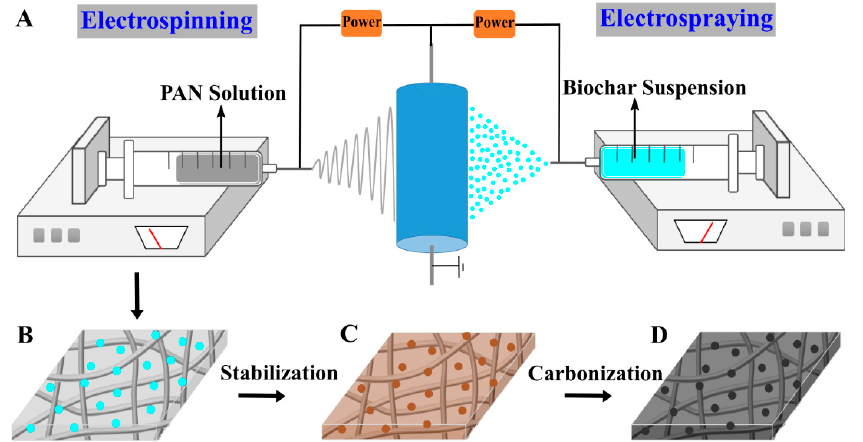
Figure 1. A schematic showing the preparation of carbon nanofibrous felt: ( A ) simultaneous electrospinning ( left ) and electrospraying ( right ), ( B ) polyacrylonitrile (PAN)/biochar precursor membrane, ( C ) stabilized membrane, and ( D ) carbon nanofibrous felt.